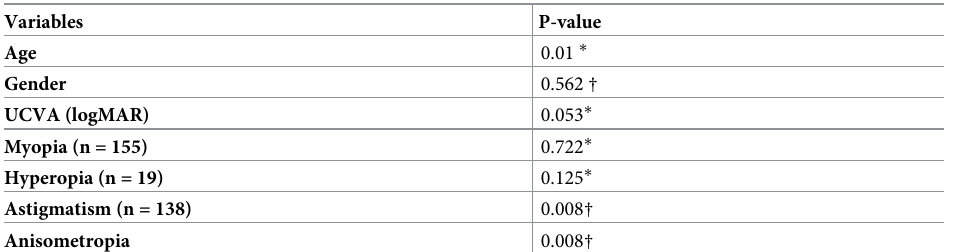
Table 2. Correlation between Titmus stereotest (log seconds) and clinical